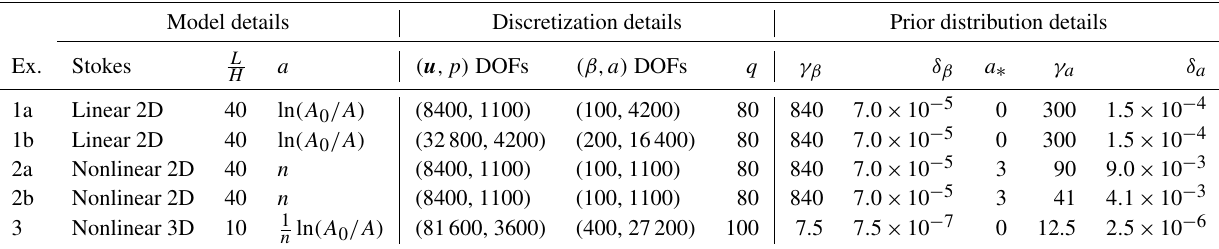
Table 1. Details for each of the examples considered. The first column (Ex.) refers to the example number; the second, third, and fourth columns give details of the forward model used, including which Stokes model is used, the aspect ratio, L , and the definition of the auxiliary H parameter; the fifth, sixth, and seventh columns give the discretization details, including the number of degrees of freedom for the velocities and pressure, the number of degrees of freedom of the unknown parameters, (β,a) DOFs, and the number of measurements, q ; finally, the 8th through 12th columns give details on the prior distributions for the unknowns, including the parameters controlling the prior covariance operator for β , the controlling parameters for the prior covariance operator of a , and the prior mean, a ∗ . Note that in examples 2a and 2b the prior for the auxiliary parameter is further constrained by enforcing 1 ≤ n( x ) , while for all examples the prior mean for the basal sliding coefficient is taken as β ∗ = 7. Furthermore, the correlation length for β in examples 1 and 2 is approximately 4900m, while in Example 3 the correlation length is approximately 3200m. Finally, in the definition of the auxiliary parameter for Example 3, the Glen’s flow law exponent is n = 3. Model details Discretization details Prior distribution details Ex.